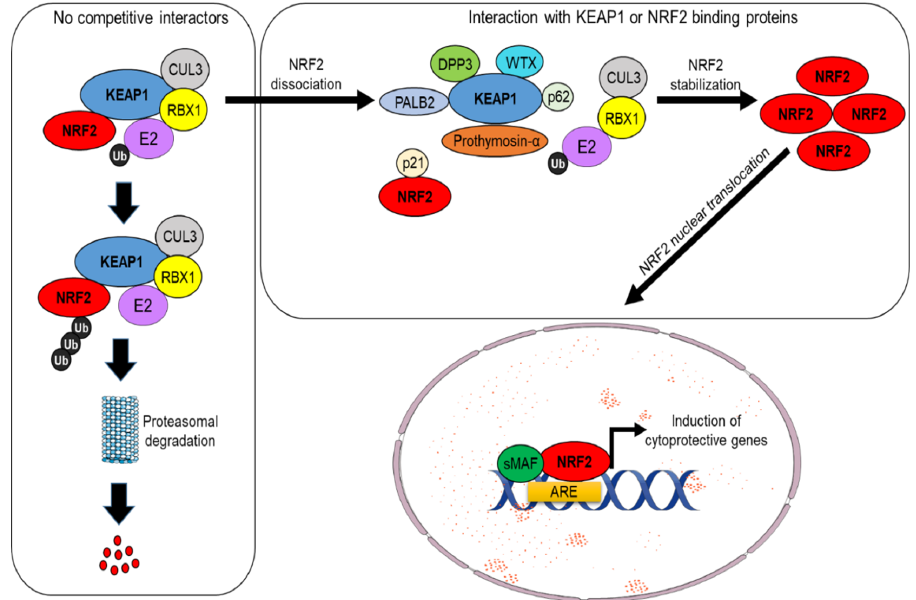
Figure 2. Non-canonical pathway of NRF2 degradation. In the absence of specific interaction partners, NRF2 ubiquitination occurs through the CUL3 ubiquitin E3 ligase complex, which promotes its proteasomal degradation. In the presence of KEAP1 binding proteins that antagonize NRF2 binding, or in the presence of NRF2 interactors that compete for KEAP1 binding, NRF2 escapes from degradation, enters into the nucleus, forms heterodimers with members of the small Maf proteins, and activates the transcription of many cytoprotective genes.